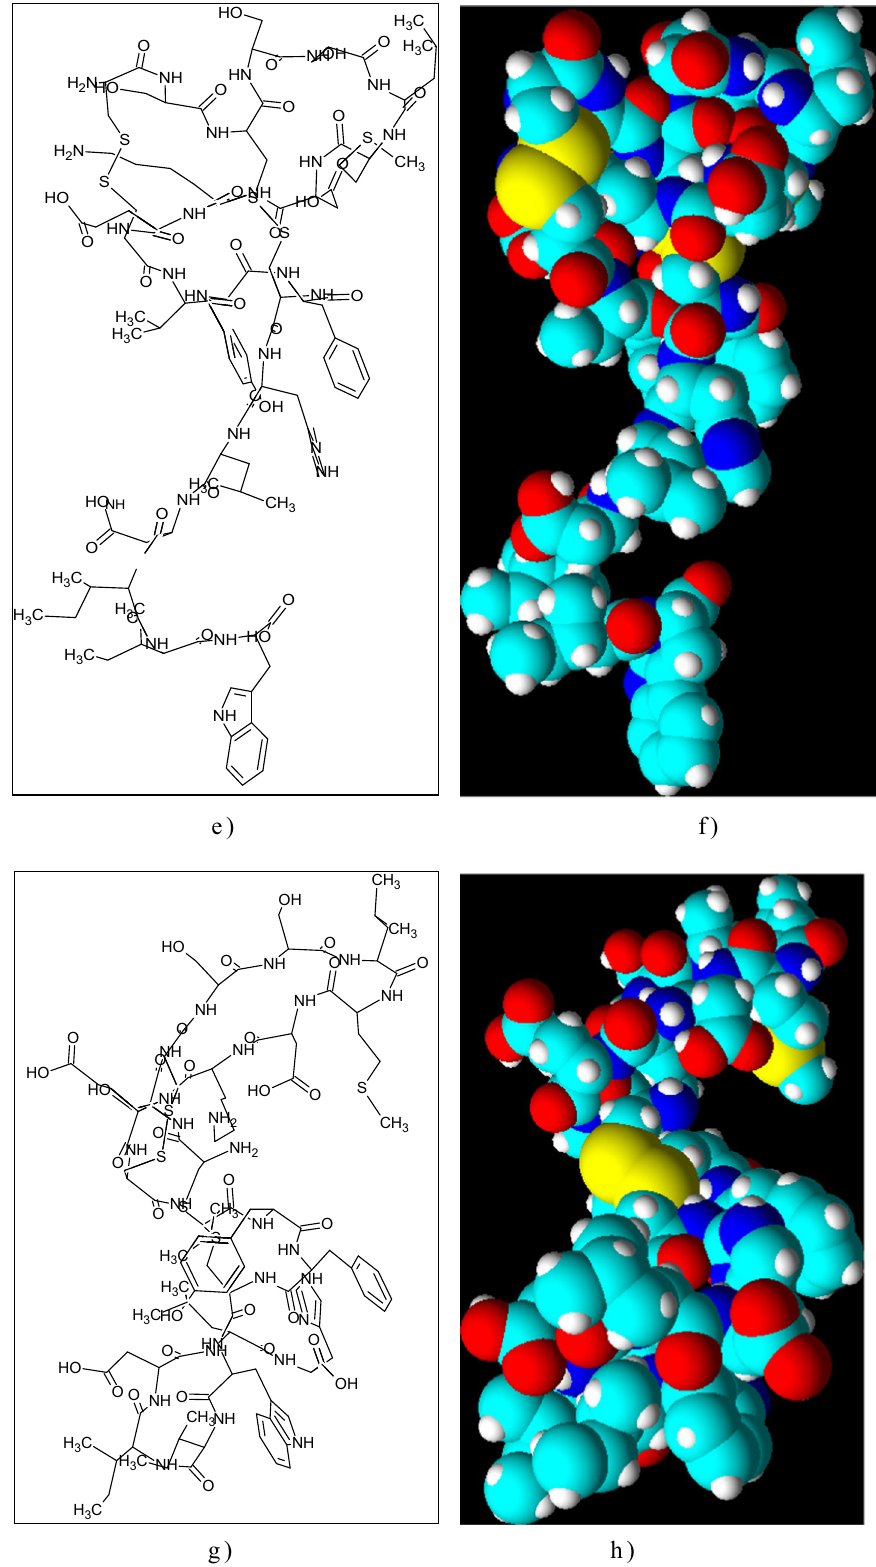
Figure 10: ET - I derived structures; structures of: ( a ) S1 ( AA 1 – 15 and 3 – 11 Cys – Cys S – S bonds ) and ( b ) S1 space - fi lling model; unusual Cys – Cys bonds ( AA 1 – 11 and 3 – 15 Cys – Cys ) models; ( c ) S16 and ( d ) S16 space - fi lling model; ( e ) S17 ( AA 1 – 11 and 3 – 15 Cys – Cys S – S bonds ) and ( f ) S17 space - fi lling model; ( g ) S18 ( AA 1 – 15 and 3 – 11 Cys – Cys S – S bonds and the Tail chain AA 16 – 21 is attached as reversed sequence, AA 21 – 16 = Tyr – Ile – Ile – Asp – Leu – His ) , and ( h ) S18 space - fi lling model. All structures are shown without explicit hydrogens, the models ’ explicit hydrogens are